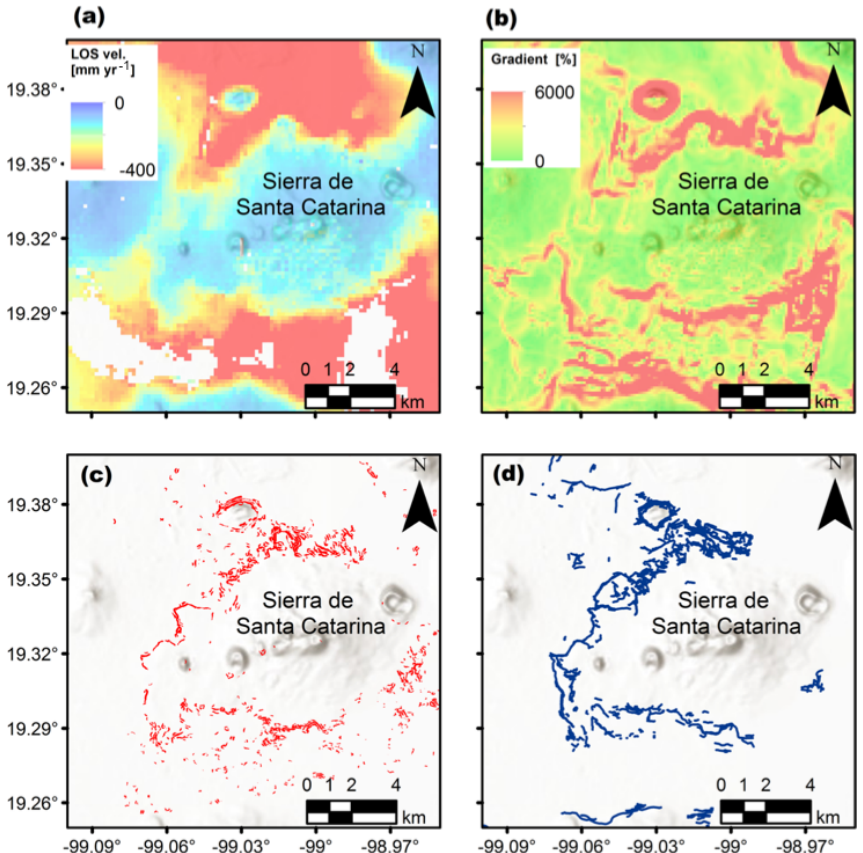
Figure 3. Case example of differential subsidence analysis over South Mexico City. (a) Velocity map from 144 Sentinel-1satellites acquired from 2014 to 2017. (b) Horizontal gradient calculated from (a) . (c) Areas of differential subsidence calculated from high-resolution COSMO- SkyMED data. (d) 10-year worth of subsidence-related shallow faults mapped by the city’s government (CENAPRED, 2017). Shaded relief from SRTM